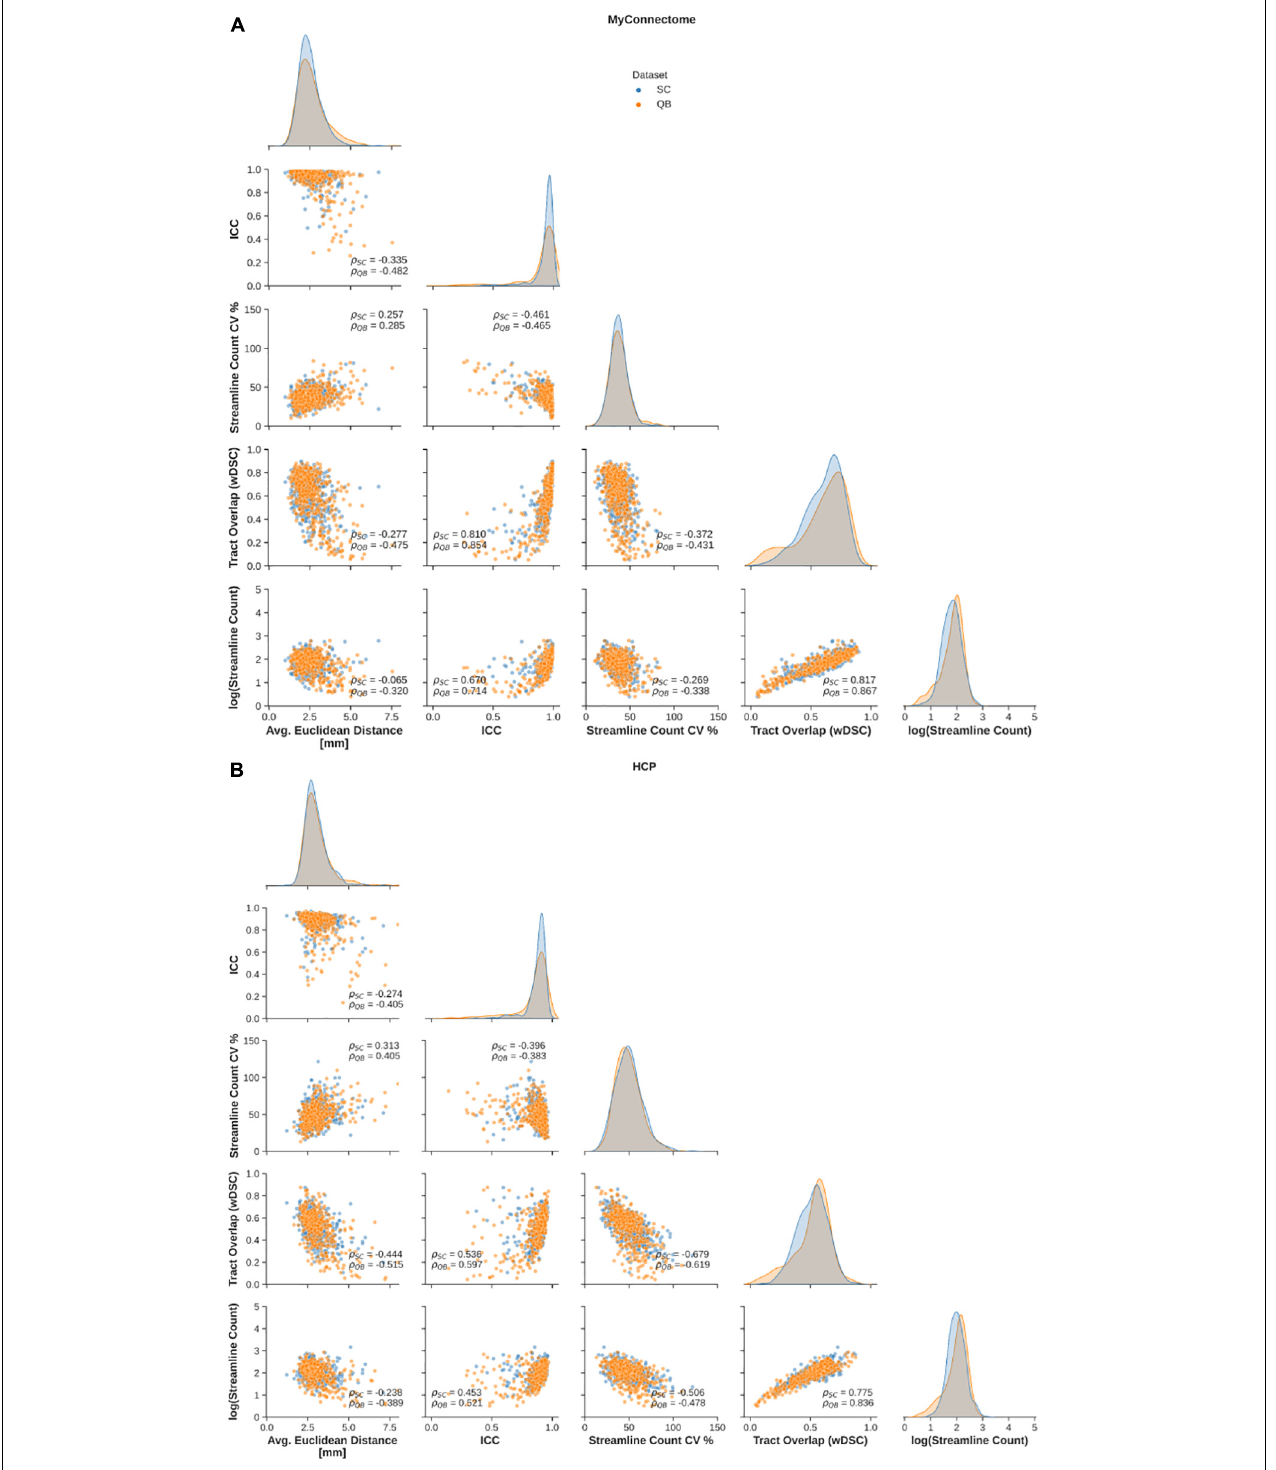
FIGURE 5 | Spearman correlations are computed to explore relationships of metrics employed to assess reliability of spectral clustered (blue circles) and QuickBundle clustered (orange circles) identified tracts in short-ranged, “U”-shaped tracts. Relationships between different metrics used for assessment are shown in pairplots for (A) MyConnectome and (B) HCP datasets. Relationships between various metrics and average Euclidean distance from an average tract centroid (left-most), relationships with along-tract absolute agreement (ICC; middle-left column), relationships with streamline count variability (middle-column) and with voxel-wise spatial overlap (middle-right column) are displayed. Distribution of observed points for a given metric (matching the x-axis) are plotted along the